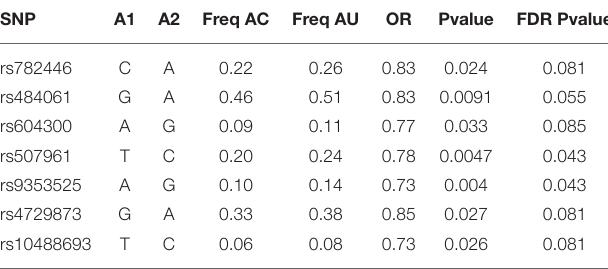
TABLE 2 | Table of results for case/control analysis ALL. SNP